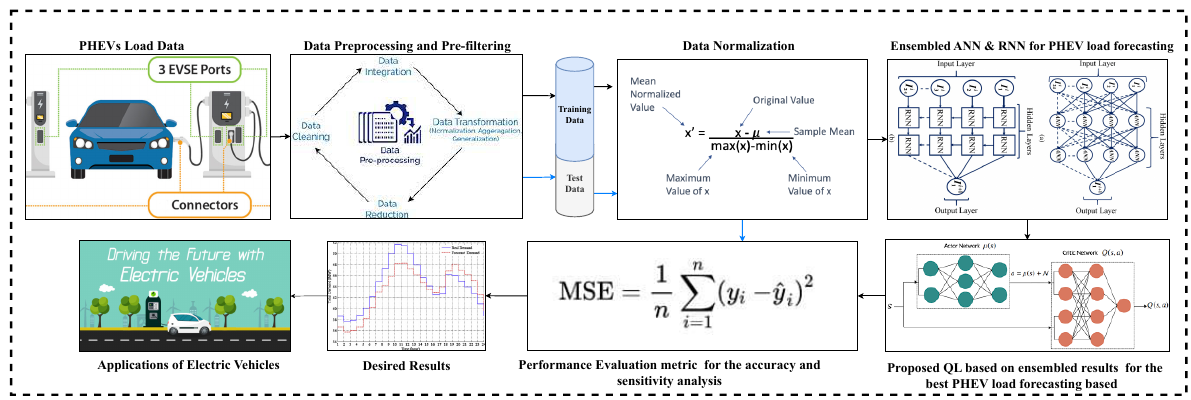
Figure 3. Proposed QL based PHEVs load forecasting Model.